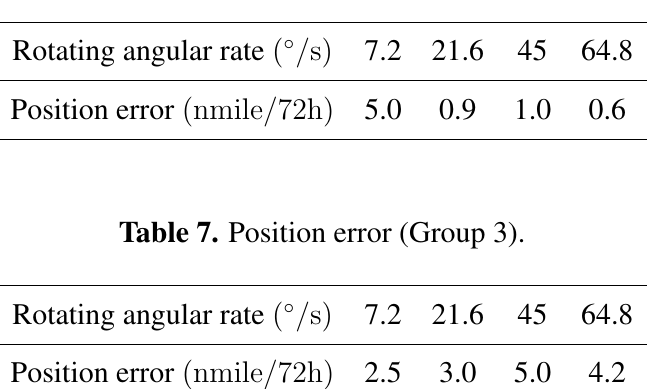
Table 6. Position error (Group 2).